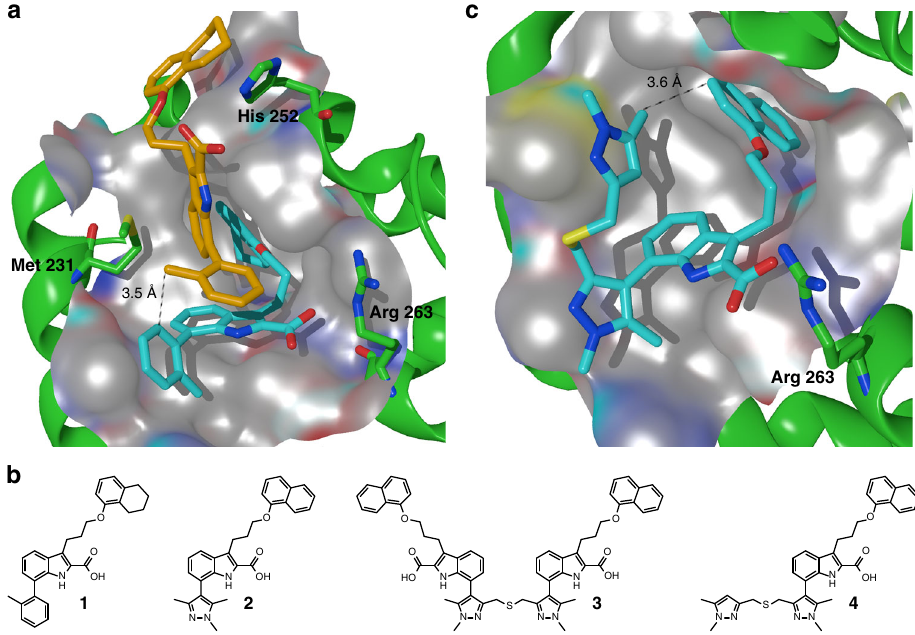
Fig. 1 Structure-based design of macrocyclic inhibitors of Mcl-1. a Crystal structure of 1 in complex with Mcl-1. Note 2:1 ligand:protein stoichiometry in binding site ( PDB ID : 6 FS 2). The protein surface around the highlighted residues has been hidden for clarity. b Literature compounds 1 and 2 , dimeric target 3 and compound synthesized from byproduct, 4 . c Crystal structure of 4 in complex with Mcl-1 ( PDB ID : 6FS1). The protein surface and alpha helix ribbon at the front of the pocket has been hidden for